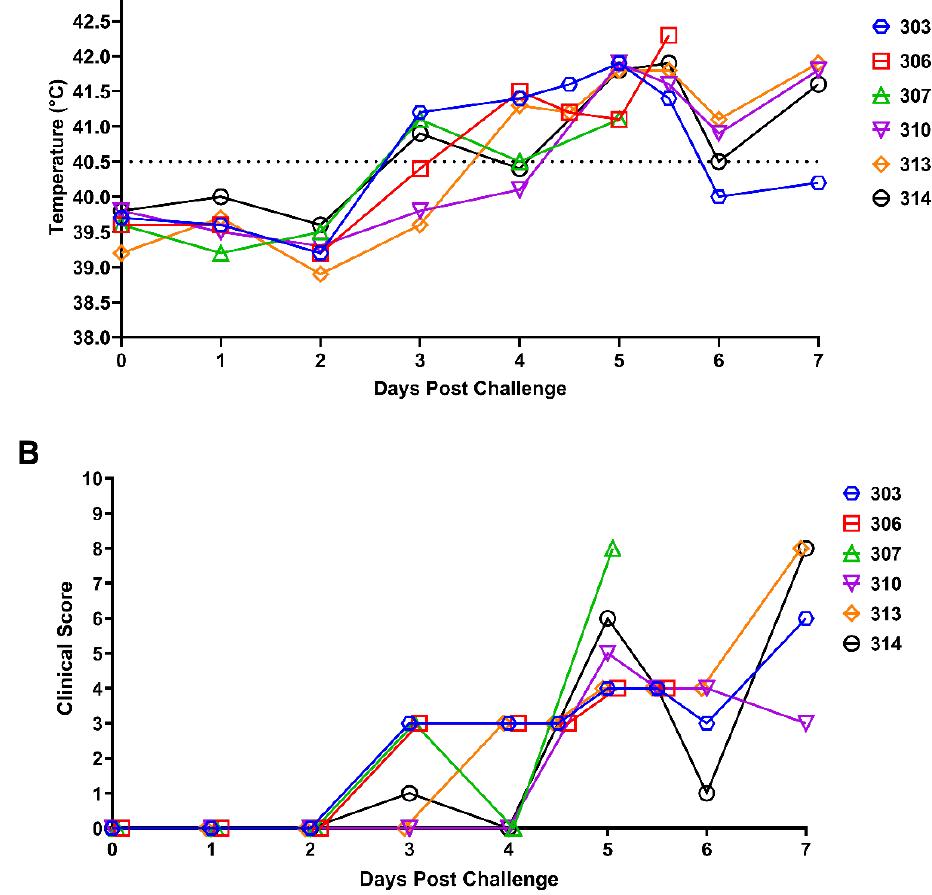
Figure 3. Clinical Observations of ASFV-MNG19 Infected Pigs. Daily body temperatures ( A ) and cumulative clinical score ( B ) of the 6 pigs challenged IM with ASFV-MNG19 from 0 DPC to 7 DPC. Data indicates individual values (( A ) expressed as °C, ( B ) expressed as an integer value). Data for individual animals are shown. The dashed line in 3A indicates 40.5 °C which is considered a fever for this study.